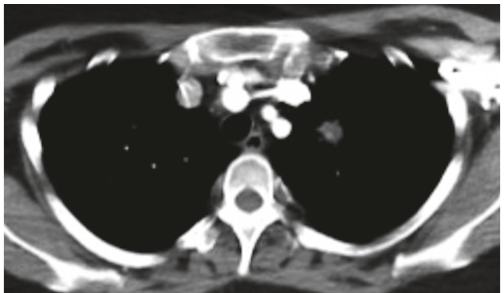
Figure 4: Commuted tomography showing 2 left upper lobe lung masses.